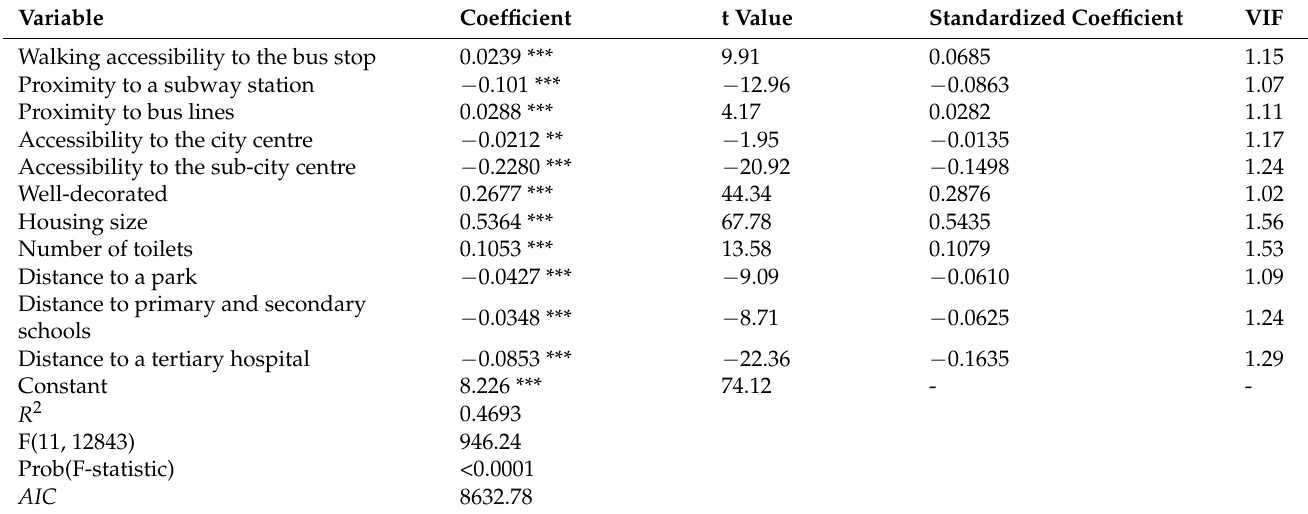
Table 2. OLS model